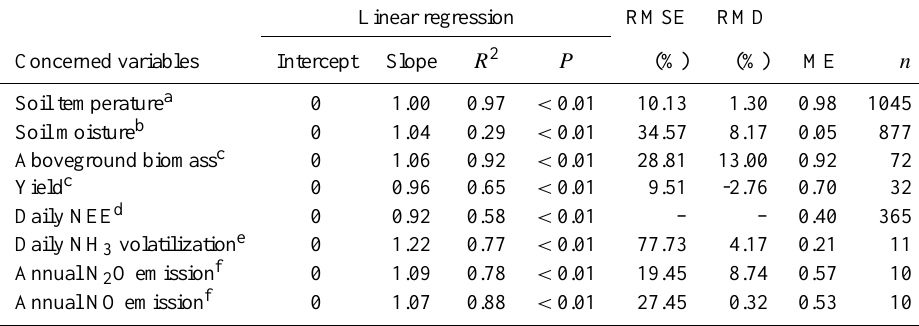
Table 3. Statistics of DNDC simulations versus observations with regards to concerned variables.